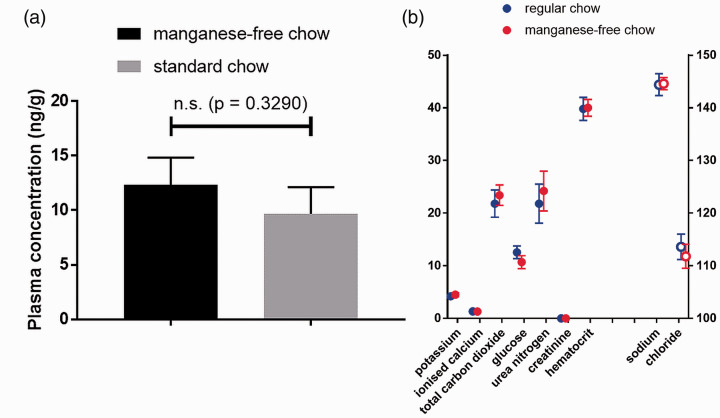
(a) Blood plasma manganese and (b) blood biochemical analyte levels for CBA/Crl mice (n = 5/group) five days post diet switch from a standard global 18% protein rodent diet to a manganese-deficient diet. The sodium and chloride electrolyte concentrations are depicted on the right y-axis for clarity. The units for sodium, potassium, chloride, ionised calcium and total carbon dioxide are mmol/L. The units for glucose, creatinine and urea nitrogen are mg/dL. Haematocrit is expressed as % packed cell volume.